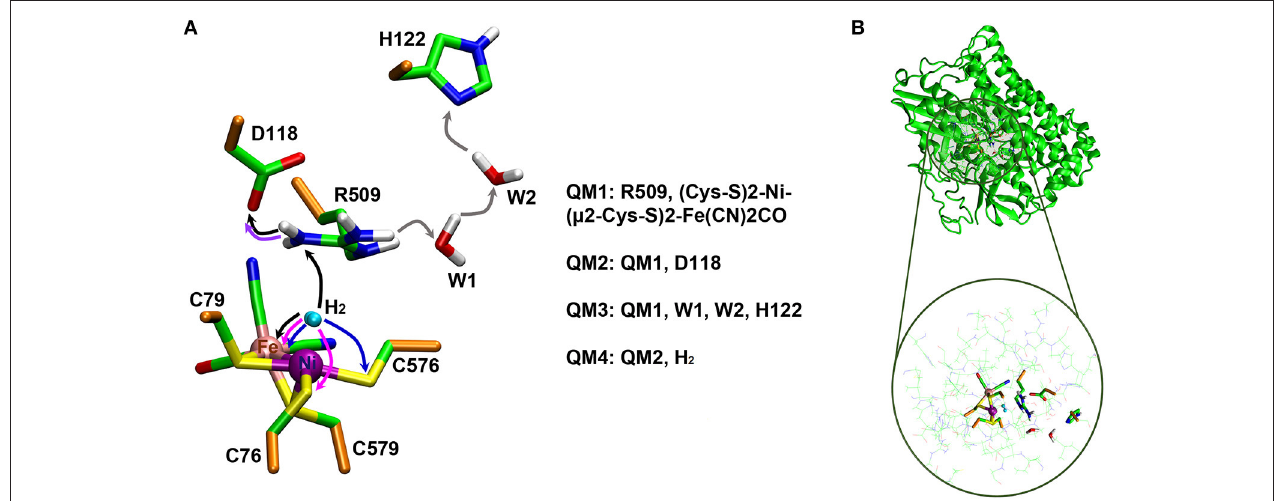
TABLE 1 | Definition of structural parameters of Arg509 coordination in the vicinity of the active site of the E. coli [NiFe]-hydrogenase. Distances /Å X-ray QM/MM Arg509 + QM1; QM2 QM/MM Arg509 0 QM1; QM2 Ni … N η 1 4.44 4.74; 4.48 4.21; 4.48 Ni … N η 2 5.45 5.71; 5.69 5.37; 5.59 Ni … N ε 4.89 4.84; 4.93 4.66: 4.76 Fe… N η 1 4.40 4.66; 4.57 4.28; 4.48 Fe … N η 2 6.27 6.46; 6.48 6.25; 6.35 Fe … N ε 5.02 5.10; 5.14 4.97; 4.98 CN … N η 1 3.22 2.90; 2.93 3.16; 3.11 CN … N η 2 5.43 5.15; 5.15 5.36;